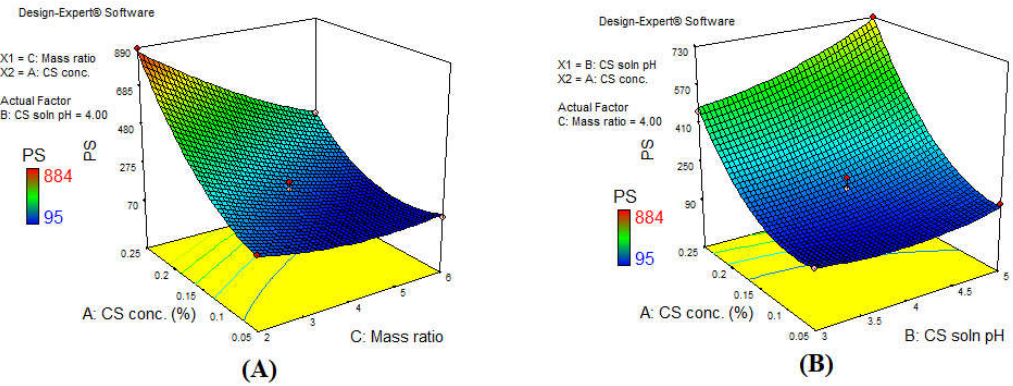
Figure 2. 3D surface plot response of the main effect of ( A ) CS concentration and CS: TPP mass ratio, and ( B ) CS concentration and CS solution pH on the PS.